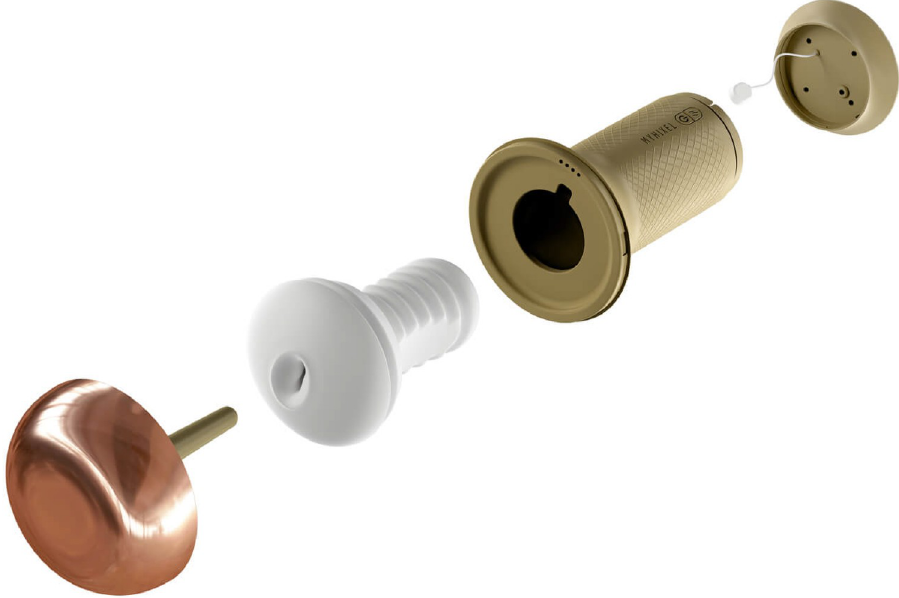
Fig 1. Device MYHIXEL I. International patented device SKU MX_PA_000. EAN 8437019695019. Dimension length: 113 mm. Width: 113 mm. Height: 203 mm. Diameter 91 mm. Weight 630 grams. Materials: thermoplastic elastomer, ABS silicone. Type of battery Lithium. Charger type, USB + Magnet